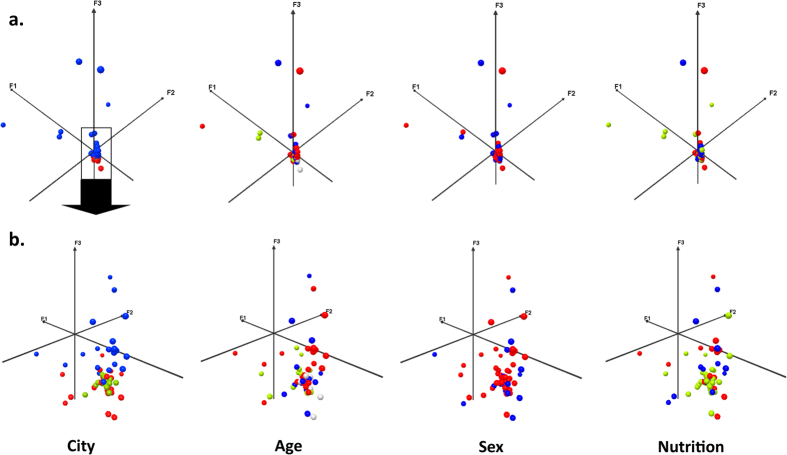
Explanatory variables of global variability of the 16S rRNA gut microbiota among 69 West African children of varying nutritional status.(a) A Pearson Principal component analysis (PCA) of the 16S rRNA gut metagenomes of 69 West African children revealed that geography was the main factor in gut microbiota variability, as only recruiting centers differentiated children into distinct groups (up). (b) In a sensitivity analysis to test the robustness of the results, a second PCA was performed excluding 10 outliers (6 healthy children and 2 children with SAM from Dakar, Senegal, and 2 children with SAM from Niamey, Niger) identified by the ROUT method (Q = 1%) based on the Euclidian distance to the framework origin24. This second PCA confirmed geography as the major determinant of the global variability of the gut microbiota among our samples (down). City: blue: Dakar (Senegal), green: Dielmo and N’Diop (contiguous villages in Senegal), red: Niamey (Niger). Age: red: up to 12 months, blue: >12 months and up to 24 months, green: >24 months, grey: missing data, Sex: red: female, blue: male, Nutritional status: green: healthy controls, red: severe acute malnutrition, blue: children with other forms of malnutrition.